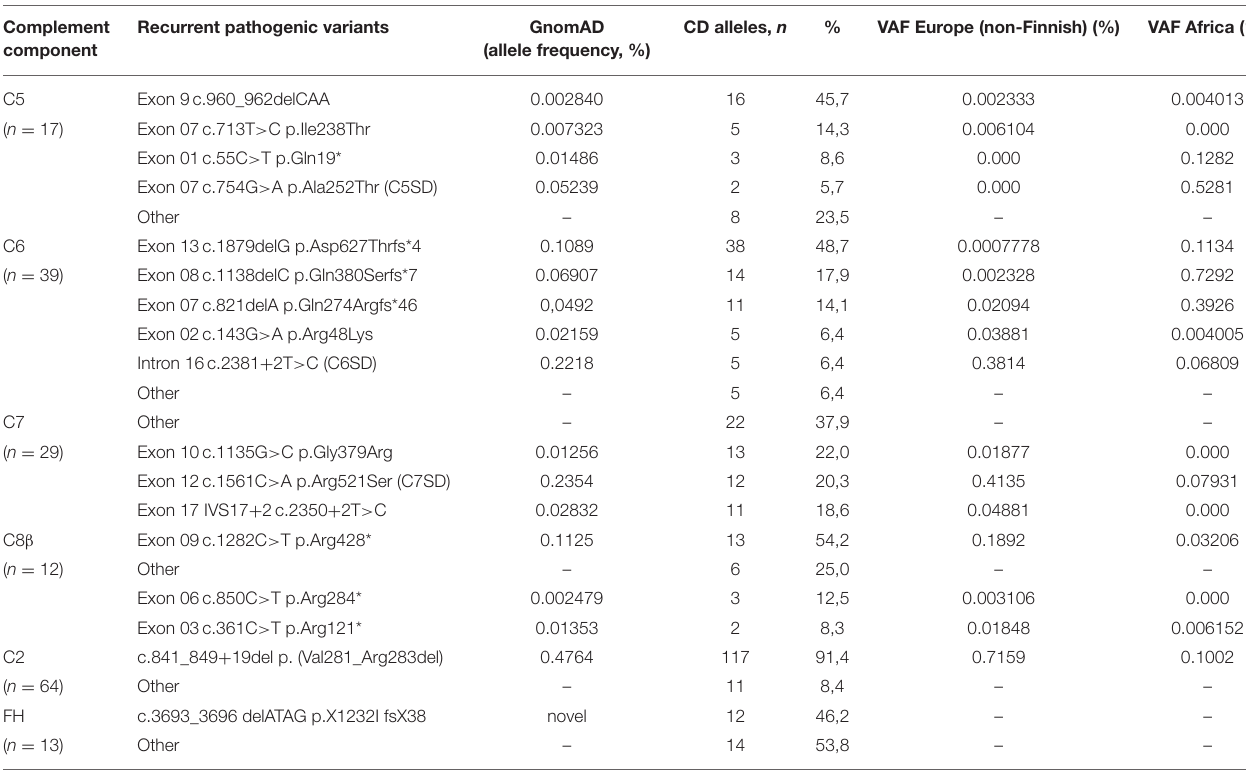
TABLE 3 | Recurrent Pathogenic rare variant identified in the cohort. Complement